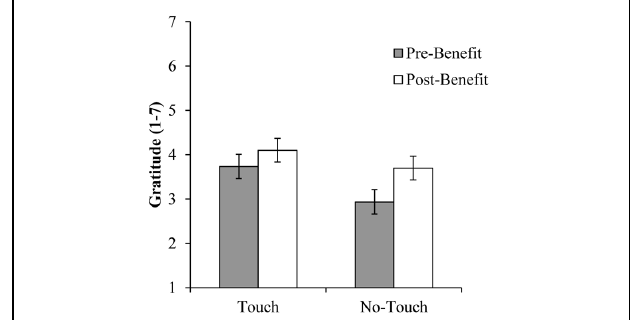
FIGURE 4 | Pre- and post-benefit gratitude as a function of touch condition, Study 2 ( N = 84). Error bars represent SEM.